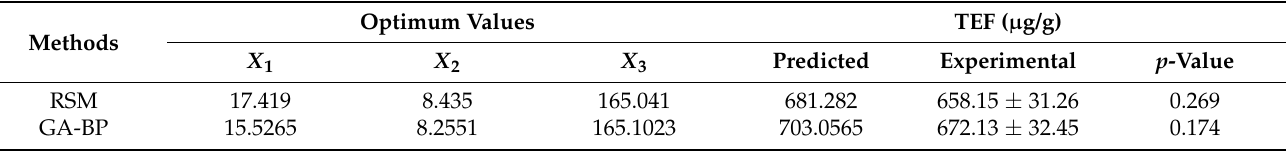
Table 3. Validation optimized conditions of RSM and GABP model.